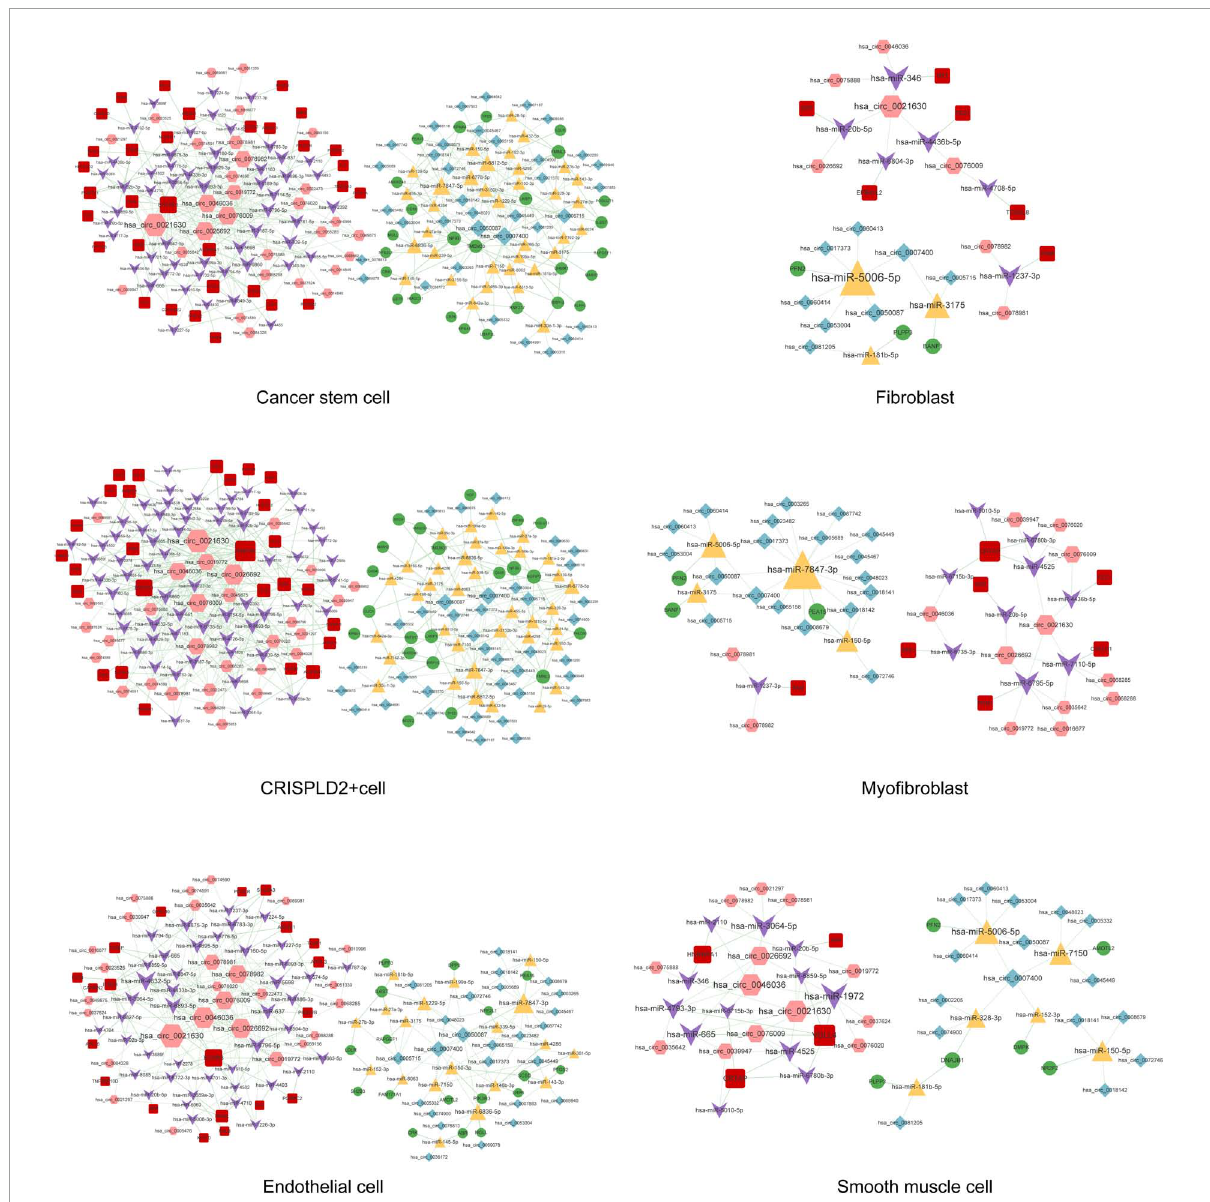
FIGURE8 The circRNA–miRNA–mRNA regulatory network in cancer stem cells, fibroblasts, CRISPLD2 + cells, myofibroblasts, endothelial cells, and smooth muscle cells. Red squares represent upregulated mRNAs; green circles represent downregulated mRNAs; yellow triangles represent upregulated miRNAs; purple arrows represent downregulated miRNAs; pink hexagons represent upregulated circRNAs; blue rhombuses represent downregulated circRNAs; dotted lines indicate competitive binding of circRNAs to miRNA; solid lines indicate regulation of mRNAs by miRNAs. The node size represents the degree of